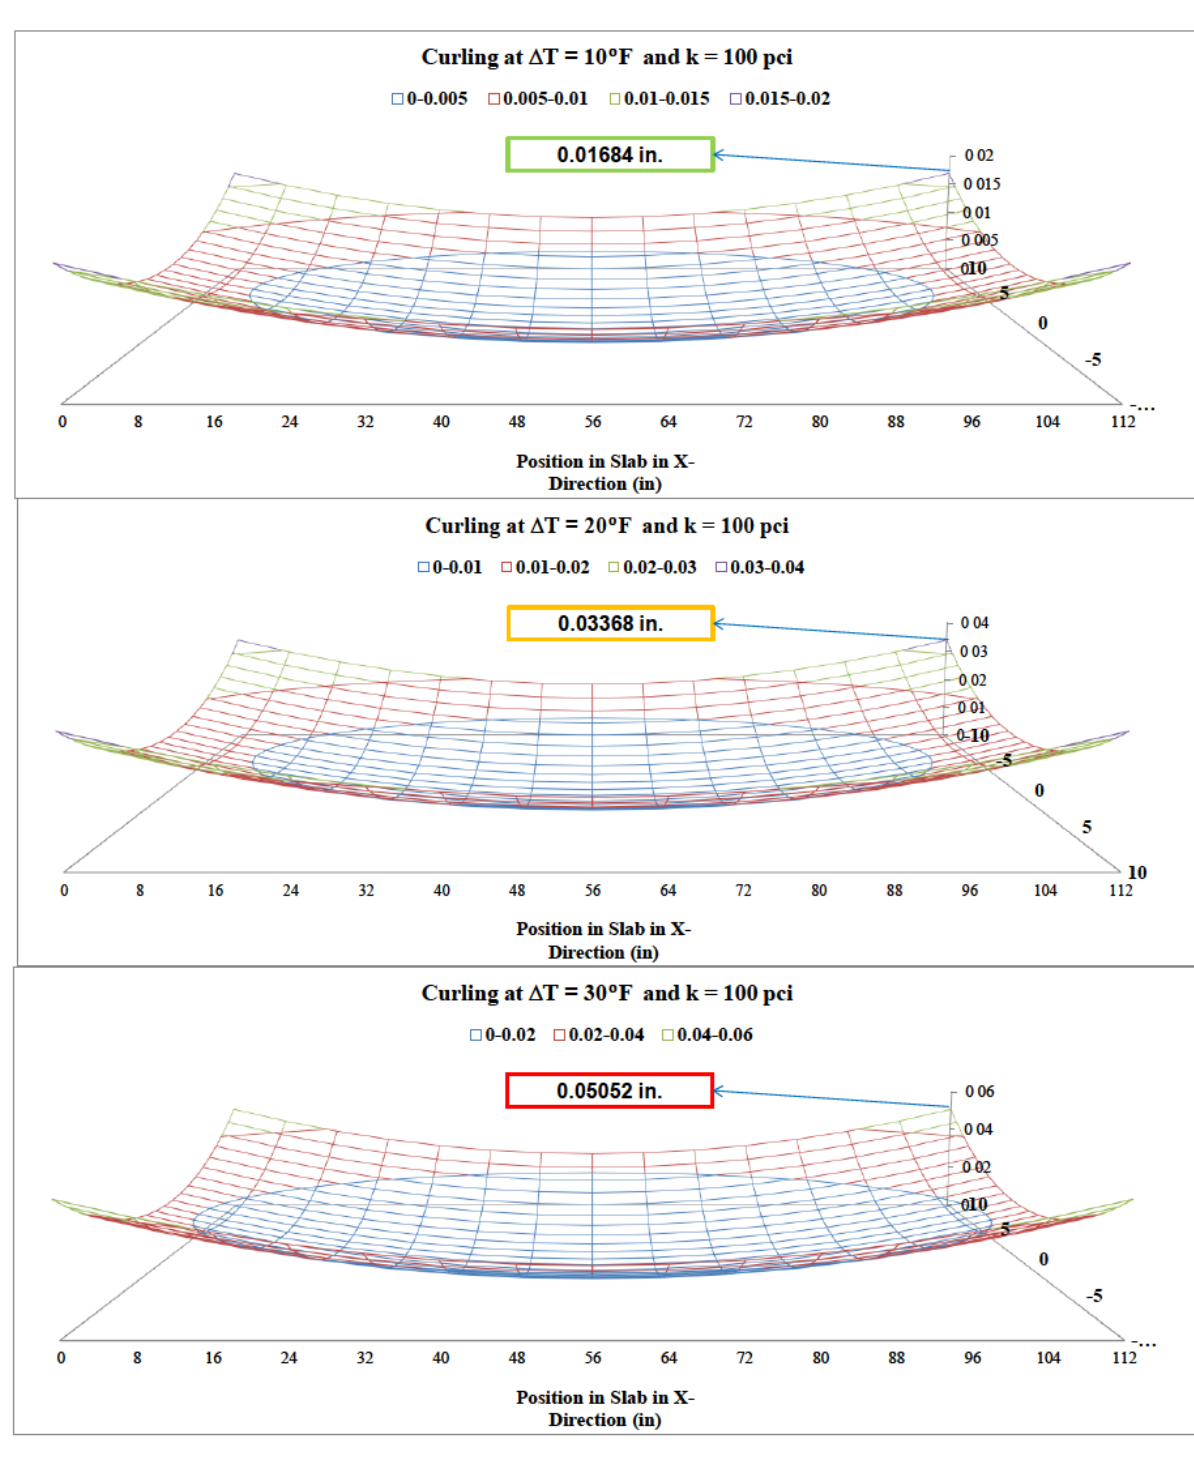
Figure 10: Curling at the same k = 100 pci with different ∆ T (10 ∘ F, 20 ∘ F, and 30 ∘